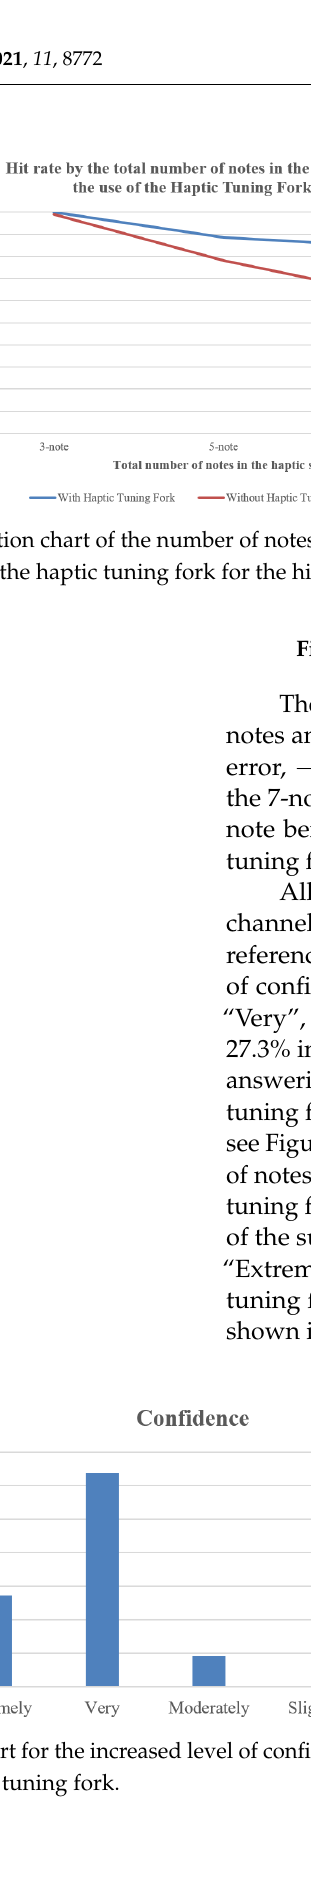
Figure 5. Subjective results for Experiment